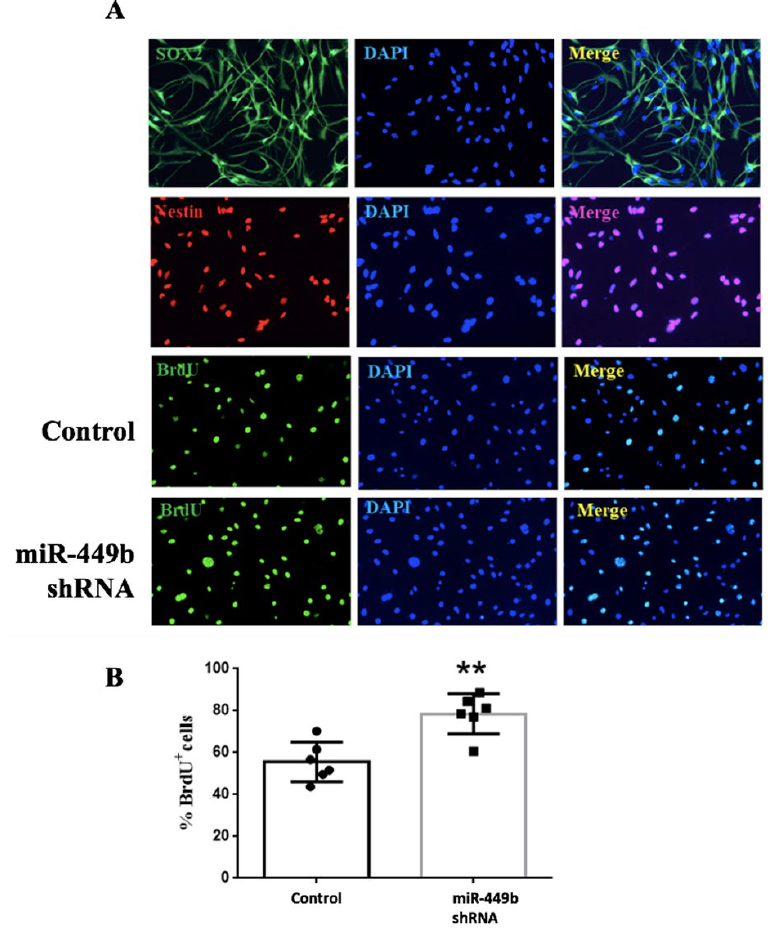
Figure 7. Effect of miR-449b on proliferation of neural stem cells. ( a ) Representative image of immunofluorescence staining. ( b ) Bar graph shows BrdU positive cells, and miR-449b inhibitor significantly increased the number of BrdU-positive cells, ** p < 0.01, N = 6 per group.